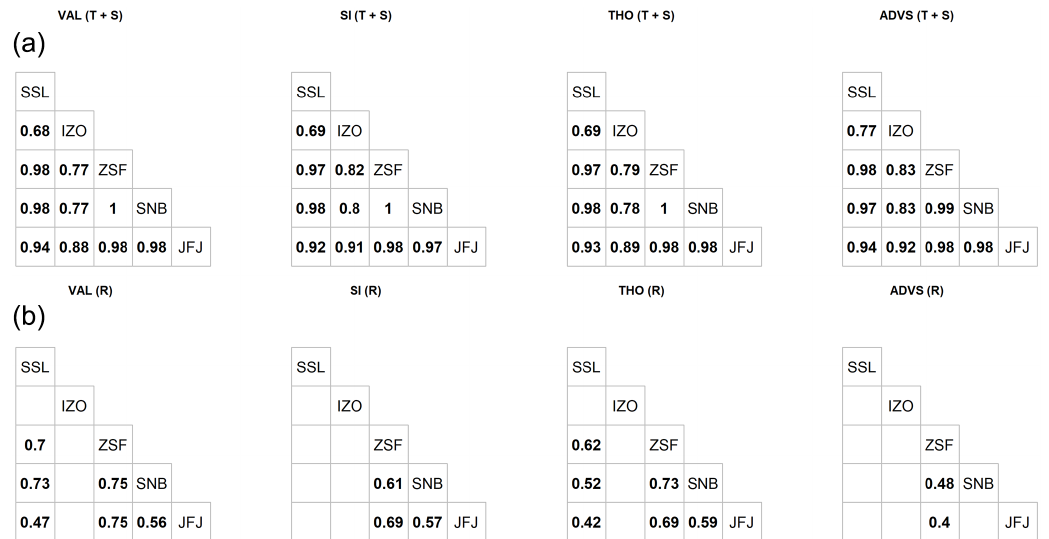
Figure 6. Pearson’s correlation matrices of combinations of trend and seasonal components ( T + S , a ), and only remainder components ( R , b ) at stations SSL, IZO, ZSF, SNB, and JFJ by different selection methods. Correlations with no significant coefficients at the 0.05 significance level were left